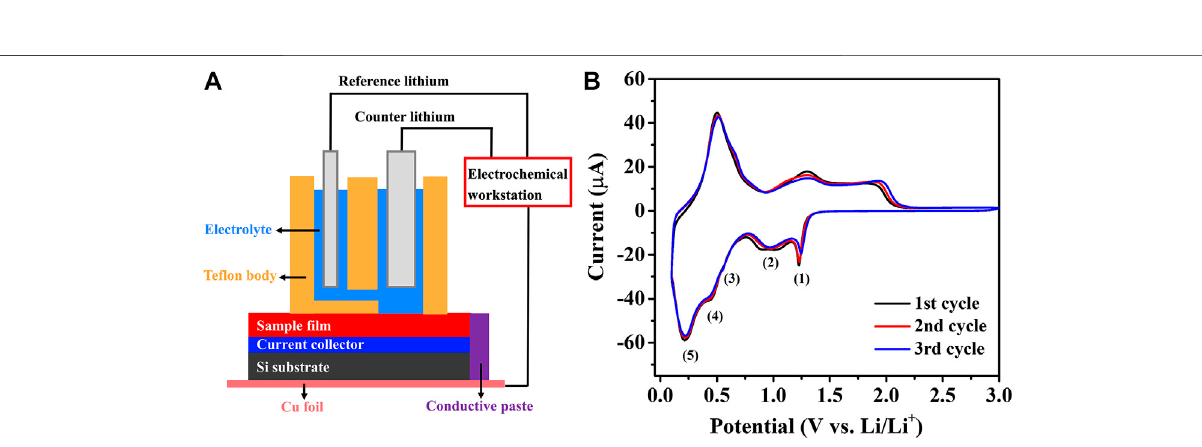
FIGURE 3 | (A) The con fi guration of battery evaluation setup used in this research. (B) Initial three cycle CV curves of ALD SnO 2 thin- fi lm electrode.